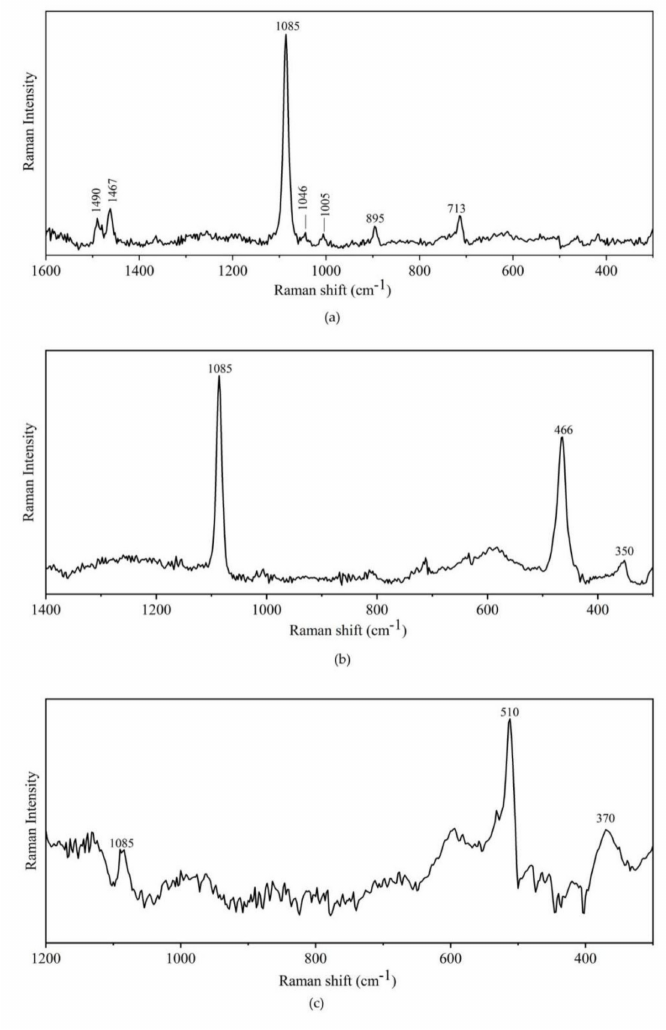
Figure 3. Portable Raman spectra of points: ( a ) M23; ( b ) MY24.1; ( c ) M43. The Raman spectrum of a brownish area (point M24.1) shows the band at 350 cm − 1 (Figure 3b) ascribable to As-S stretching vibrational mode [34] of the orpiment pigment together with quartz signal at 466 cm − 1 [32], which one evidenced also in M19 and M20. The signals at 510 and 370 cm − 1 (Figure 3c) identified in a reddish area (point M43) has ascribed to feldspar minerals